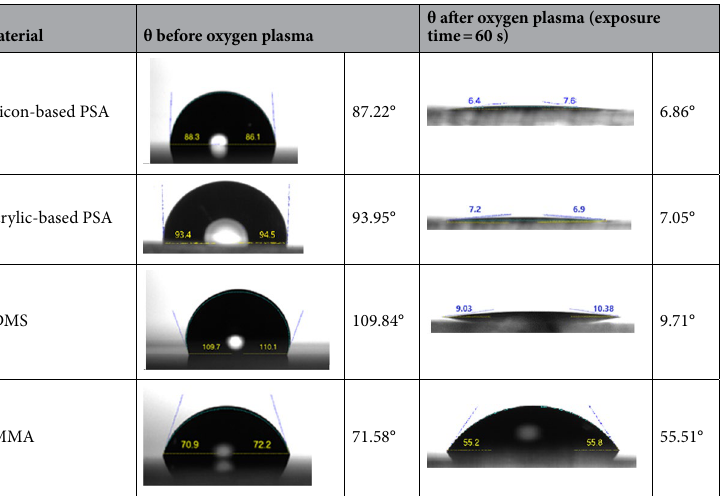
Table 2. Water contact angles (θ) measured for oxygen plasma-treated and untreated surfaces. According to the Young’s equation (γs = γsl + γl cos θ), the contact angle of a liquid drop on a solid surface (θ) is defined by the action of liquid surface tension (γl), solid–liquid interfacial tension (γsl), and solid surface tension (γs) (which is surface free energy of the solid) 51 .